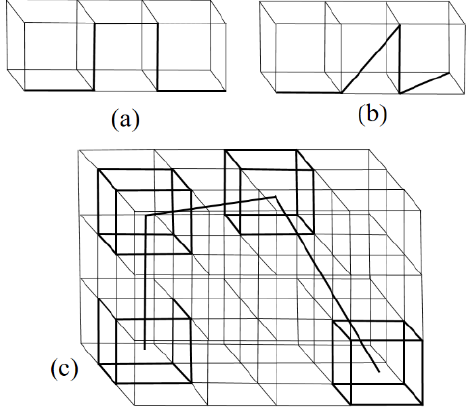
Figure 1. The illustration of lattice Monte Carlo simulations: ( a ) A simple cubic lattice model (SCLM); ( b ) a Larson-type bond fluctuation model (L-BFM); ( c ) a bond fluctuation model (BFM).